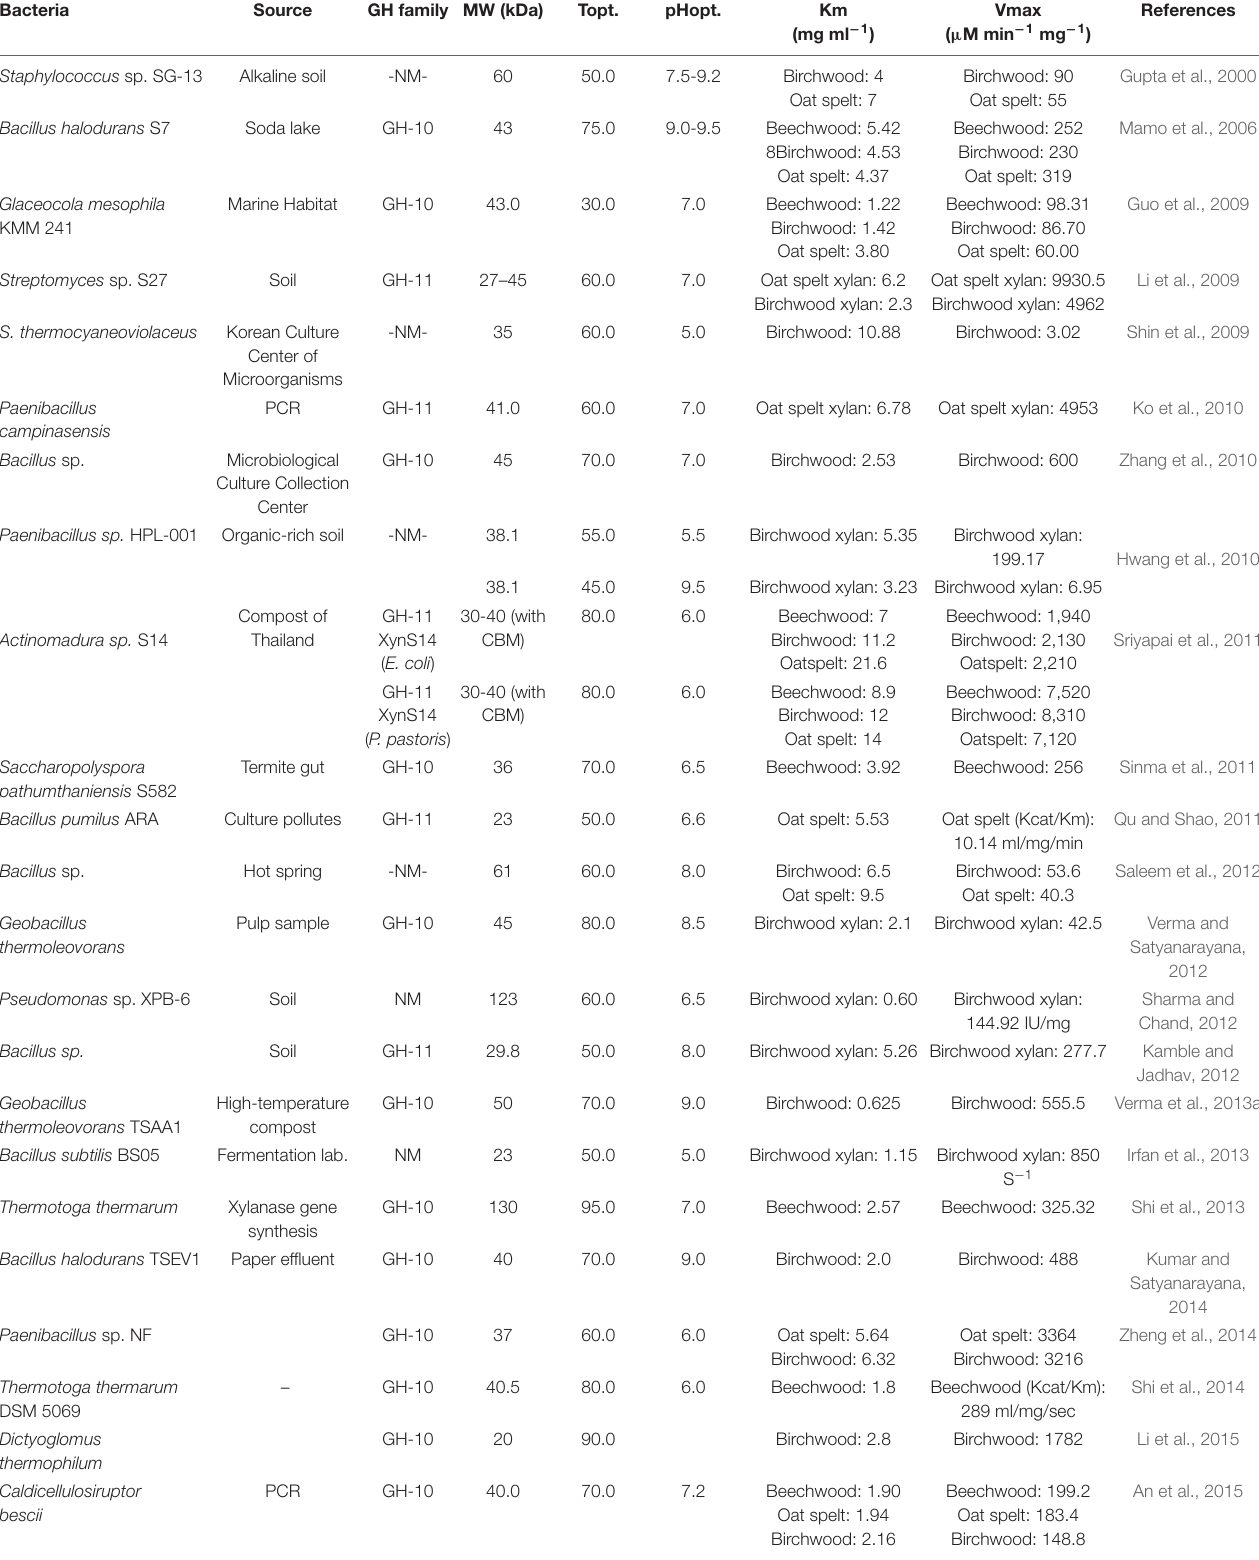
TABLE 1 | Characteristics of extremophilic endoxylanases from various prokaryotic